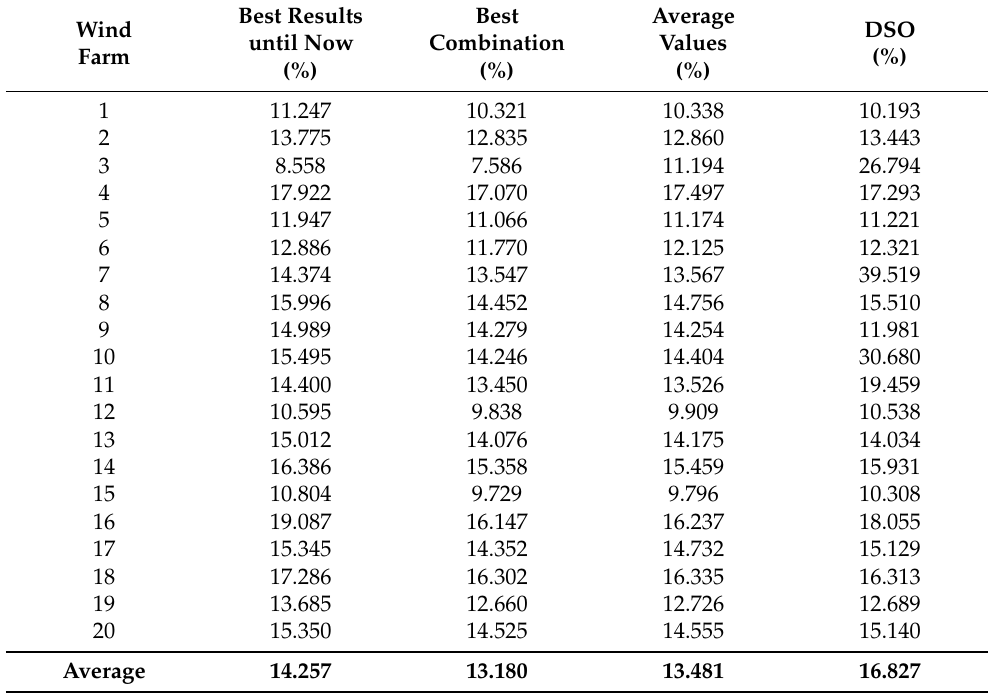
Table 5. RRMSE for XGBOOST after hyperparameter tuning: 1-year training, 6 months